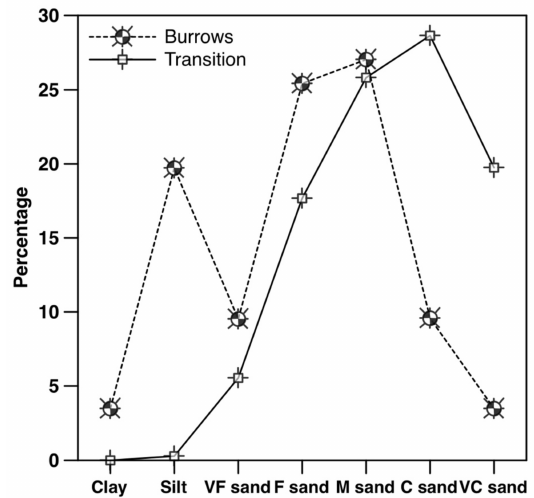
Figure 5. Percentage distribution of the several sediment grain size classes of the U. noronhensis burrow walls and adjacent sediments of the transition zone. VF sand = very fine sand; F sand = fine sand; M sand = medium sand; C sand = coarse sand; VC sand = very coarse